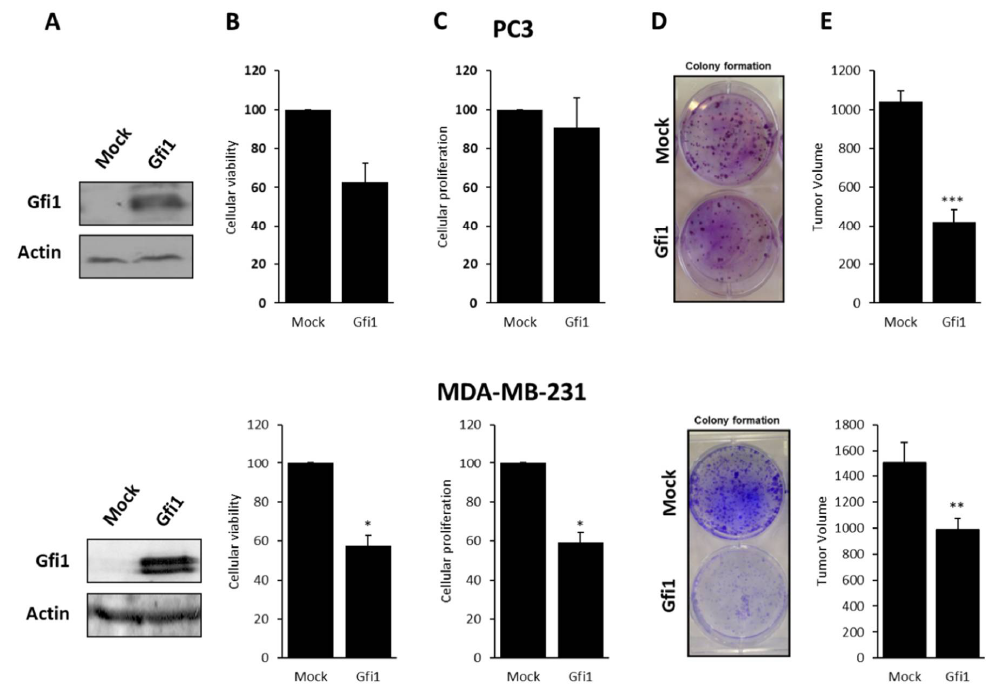
Figure 3. Tumor-suppressor-like properties of Gfi1 re-expression. ( A ) Western Blot showing Gfi1 expression in empty vector and Gfi1-transfected PC3 and MDA-MB-231 cells. ( B ) Effect of Gfi1 expression on PC3 and MDA-MB-231 cellular viability monitored by MTT assay. ( C ) Cell proliferation of empty vector and Gfi1-transfected PC3 and MDA-MB-231 cells. ( D ) Colony formation assay of PC3 and MDA-MB-231 cells transfected with the empty vector or with Gfi1. ( E ) Effect of Gfi1 transfection on the in vivo growth of PC3 and MDA-MB-231 cells. Tumor size was monitored over time, and size is shown in cubic millimeters. * p < 0.05, ** p < 0.01, *** p < 0.001 . Then, we moved to the in vivo experiments by analyzing the ability of Gfi1-transfected MDA- MB-231 and PC3 cells to form tumors in nude mice compared to the empty vector-transfected cells.